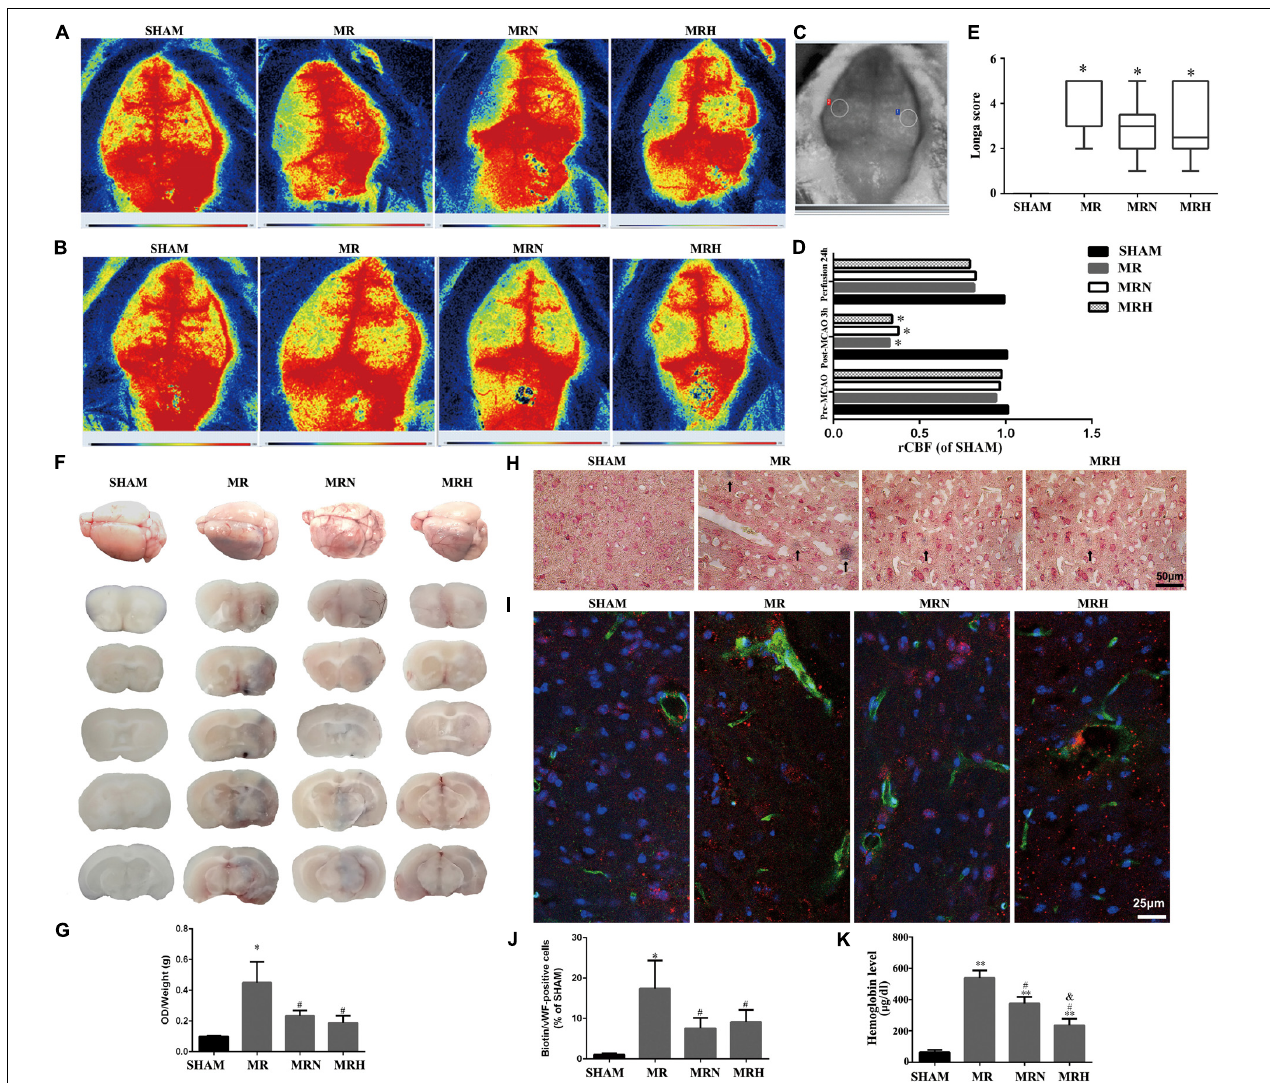
FIGURE 2 | Rosuvastatin decreased BBB permeability at 24 h following rt-PA reperfusion after brain ischemia but did not alter cerebral blood reflow. (A) Representative images of CBF before reperfusion in SHAM, MR, MRN and MRH groups captured by 2-D laser speckle imaging. (B) Representative images of CBF after 24 h reperfusion in SHAM, MR, MRN, and MRH groups captured by 2-D laser speckle imaging. (C) Circles indicate the monitored areas. (D) The rCBF results were expressed as fold changes of the ROI ratio to the right side (rCBF), n = 6. ∗ P < 0.05 compared to the corresponding SHAM value. (E) Neurological deficits were evaluated in a blinded manner by determining the Longa score before MCAO and at 24 h after reperfusion in the SHAM group, mice that underwent MCAO for 3 h followed by rt-PA reperfusion for 24 h (MR), mice pretreated with a normal dose of rosuvastatin (1 mg/kg) prior to MCAO for 3 h followed by rt-PA reperfusion for 24 h (MRN), and mice pretreated with a high dose of rosuvastatin (5 mg/kg) prior to MCAO for 3 h followed by rt-PA reperfusion for 24 h (MRH) groups. The Kruskal–Wallis test and Wilcoxon non-parametric test were used to compare the mean infarct volumes among the groups at a significance level of 0.05. (F) Representative whole-brain and coronal sections of mouse brains after a MCAO and after 24 h reperfusion. The dark blue color indicates clusters of bleeding areas stained by Evans blue. Data are presented as the means + SEM, n = 5; ∗ P < 0.05 compared to SHAM, # P < 0.05 compared to MR. (G) The levels of Evans blue leakage in the brain were quantified spectrophotometrically in the supernatant at 620 nm and normalized to hemispheric weights (OD/ µ g). (H) Perls’ iron staining was used to visualize microvascular hemorrhages. The dark blue area indicated by a black arrow is associated with a hemorrhage. Scale bar, 50 µ m. (I) Representative images showing the Sulfo-NHS-Biotin tracer extravasation assay. The leakage of biotins (green) from vessels is shown (red staining represents vWF-positive cells). Scale bar = 25 µ m. (J) Quantitative analysis of the percentage of biotin/vWF-positive cells normalized to the SHAM group. Data are presented as the means + SEM, n = 5; ∗ P < 0.05 compared to SHAM, # P < 0.05 compared to MR. (K) Quantitative analysis of intracerebral hemorrhages using a hemoglobin assay. Data are presented as the means + SEM, n = 4; ∗∗ P < 0.01 compared to SHAM, # P < 0.05 compared to MR, & P < 0.05 compared to MRN.